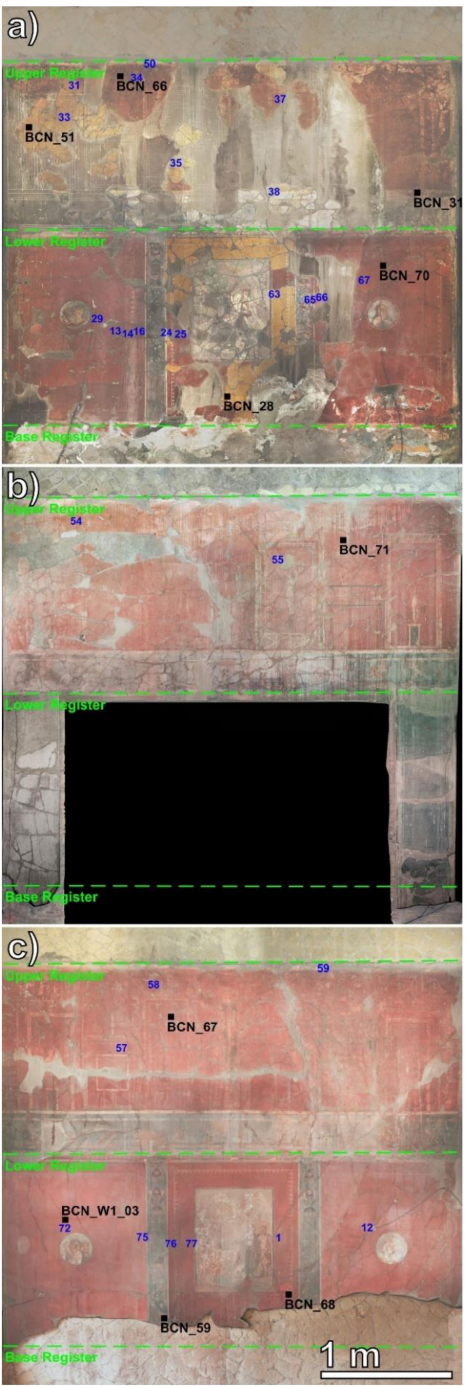
Figure 2. Orthophotos of the walls of the tablinum: ( a ) east wall; ( b ) south wall; and ( c ) west wall. The three registers are indicated by green dashed lines. The spots where X-ray fluorescence (p-XRF) analyses on the monochrome backgrounds were performed are indicated by blue numbers. The sampling positions of the analyzed materials are indicated by black